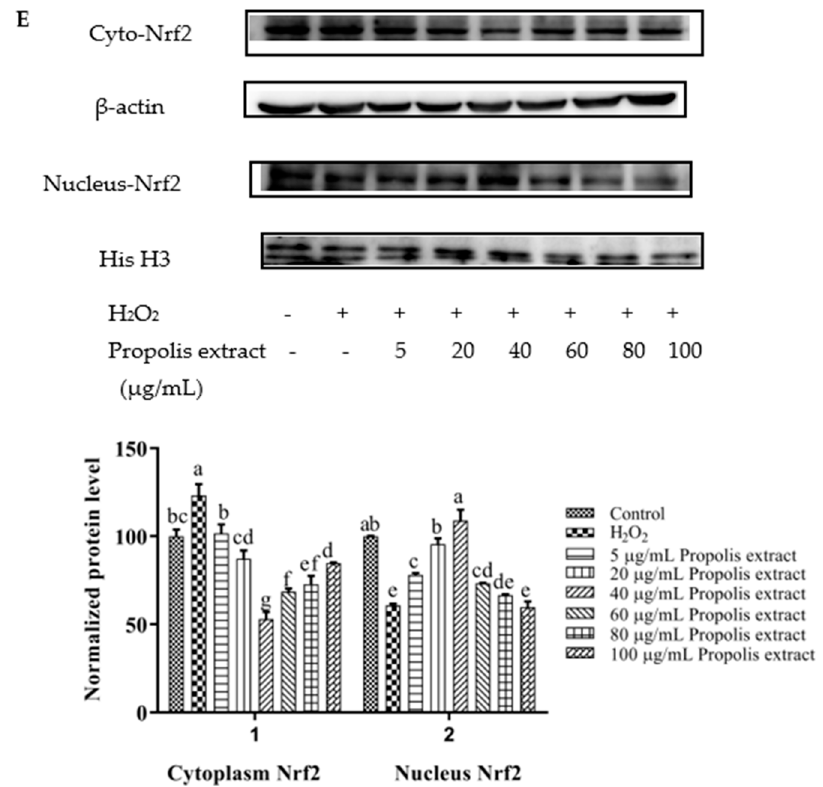
Figure 7. Expression of Nrf2 nuclear translocation induced by individual flavonoids (chrysin, pinocembrin, galangin, and pinobanksin) and propolis extract in 150 µ M H 2 O 2 -induced H9c2 cells. H9c2 cells were stimulated with different concentrations of phytochemicals (chrysin, pinocembrin, galangin, pinobanksin, and propolis extract) for 12 h and then treated with 150 µ M H 2 O 2 for 1 h; finally, protein expression was detected via Western blot. β -actin was used as an internal control. ( A ) Expression of Nrf2 nuclear translocation in chrysin-induced H9c2 cells. ( B ) Expression of Nrf2 nuclear translocation in pinocembrin-induced H9c2 cells. ( C ) Expression of Nrf2 nuclear translocation in galangin-induced H9c2 cells. ( D ) Expression of Nrf2 nuclear translocation in pinobanksin-induced H9c2 cells. ( E ) Expression of Nrf2 nuclear translocation in propolis-extract-induced H9c2 cells. Values are expressed as the mean ± SEM ( n = 3). Values with different (a, b, c, d, e, f, g) letters in the figure showed significant differences at p < 0.05.